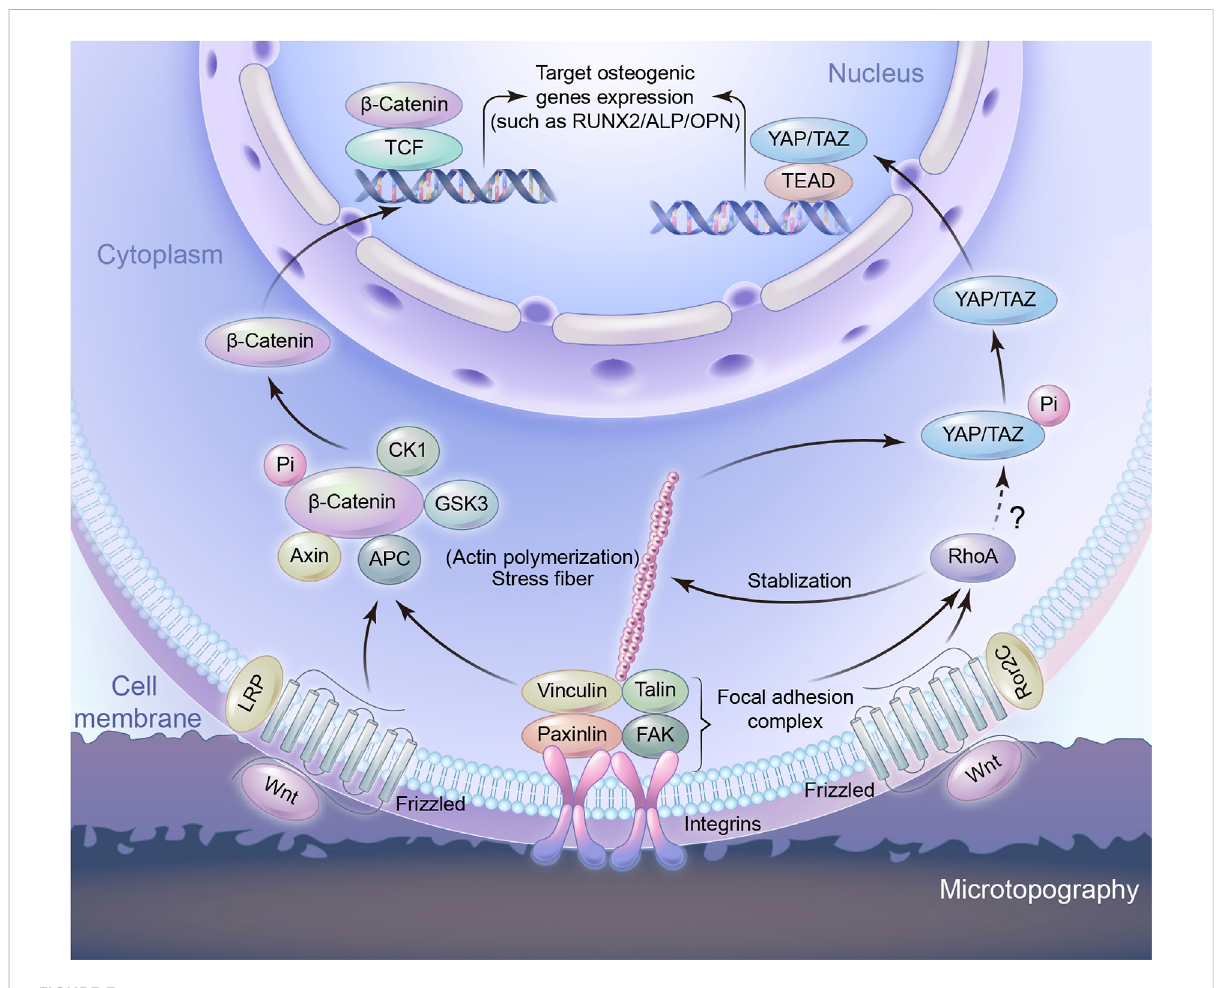
FIGURE 3 Schematic representation of signaling pathways to regulate osteogenic gene expression induced by